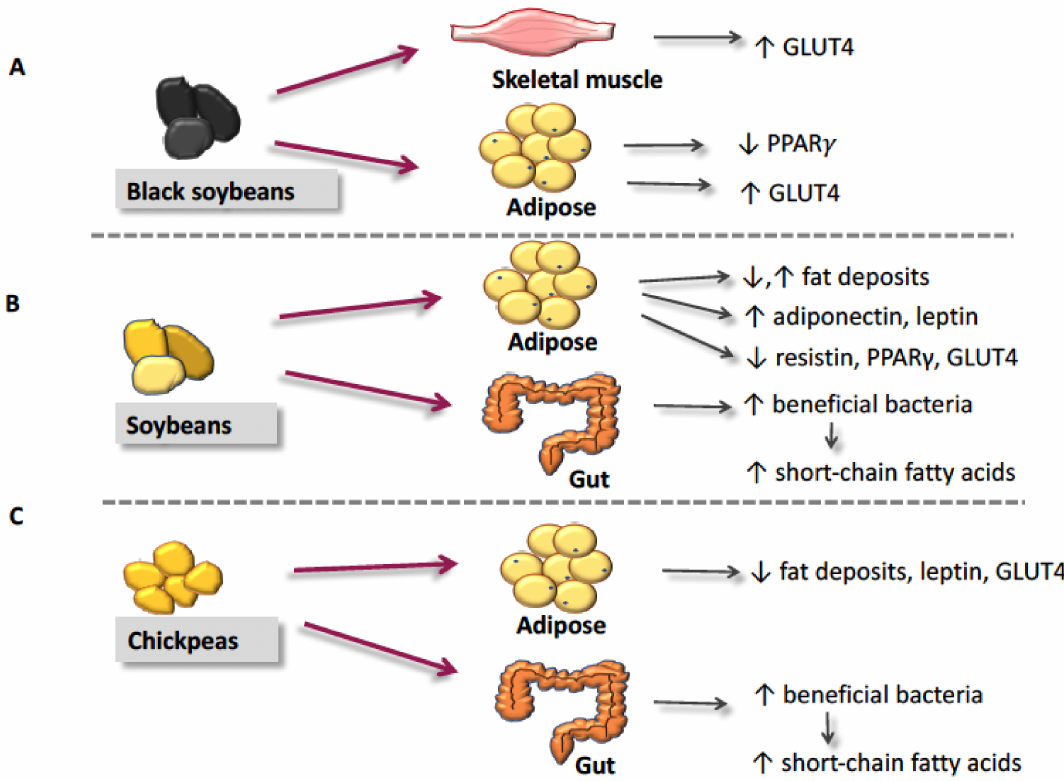
Figure 2. The proposed processes initiated by soybeans and chickpeas that lead to improved insulin sensitivity. ( A ) The actions of black soybeans in target tissues. ( B ) The actions of yellow soybeans in target tissues. ( C ) The actions of chickpeas in target tissues. Abbreviations: ↓ , decrease; ↑ , increase; GLUT4, glucose transporter-4; PPAR γ , peroxisome proliferator-activated receptor- γ